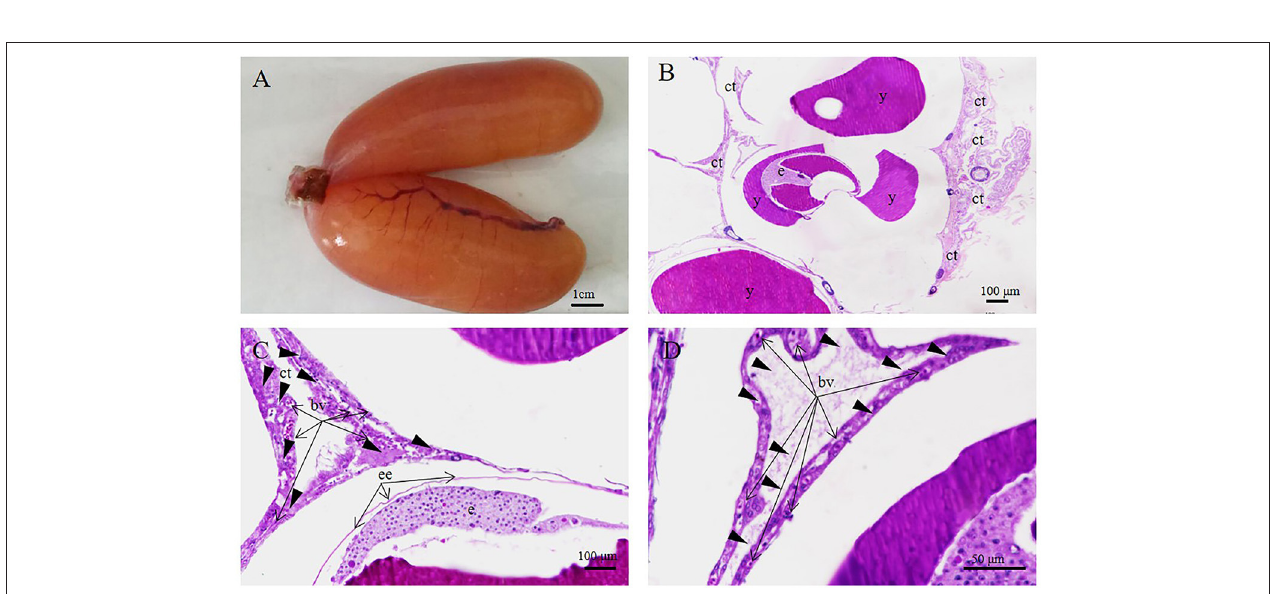
FIGURE 9 | S. schlegelii embryos in the cleavage stage. (A) Fleshy ovaries, (B) Loosely arranged embryo (e) with connective tissue (ct) attached. (C,D) Numerous blood vessels (bv) in the connective tissue (ct). Scale bars, 1cm (A) ; 100 µ m (B,C) ; 50 µ m (D) . HandE stained.